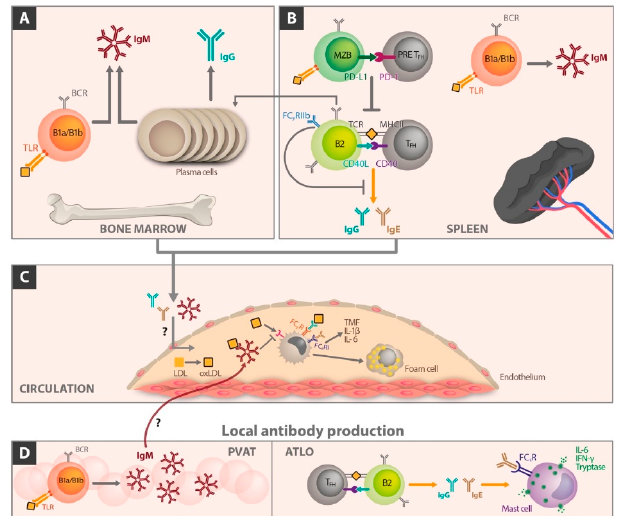
Figure 2. B cell subsets and peripheral immunoglobulin production in atherosclerosis. ( A )